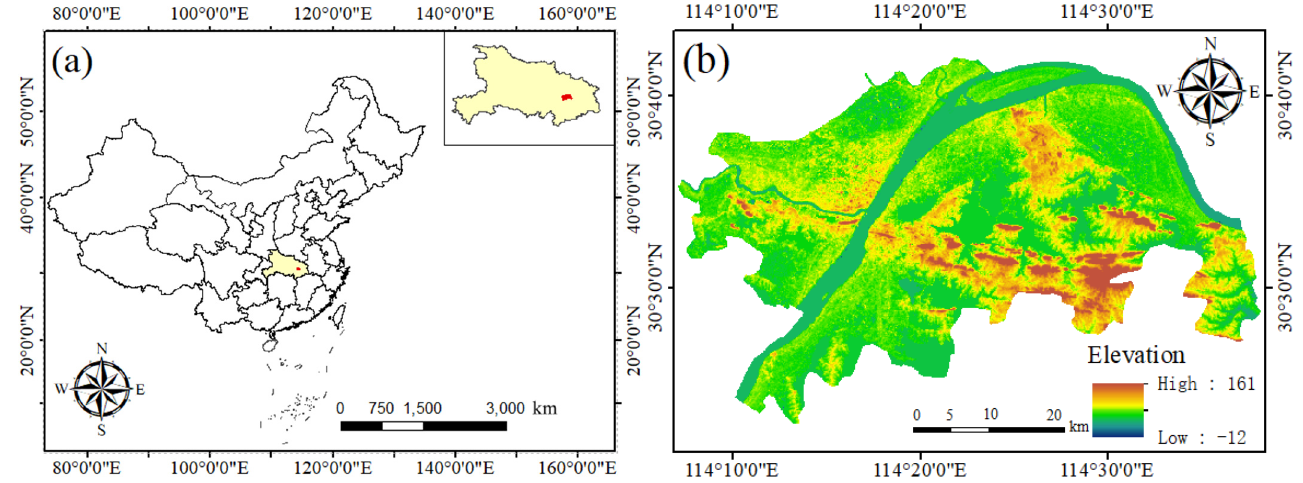
Figure 1. Location map of the study area ( a ) and elevation map of the study area ( b ).